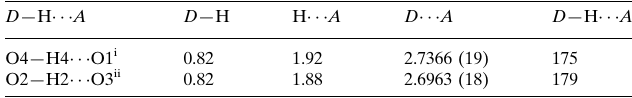
Hydrogen-bond geometry (A˚ , (cid:4)